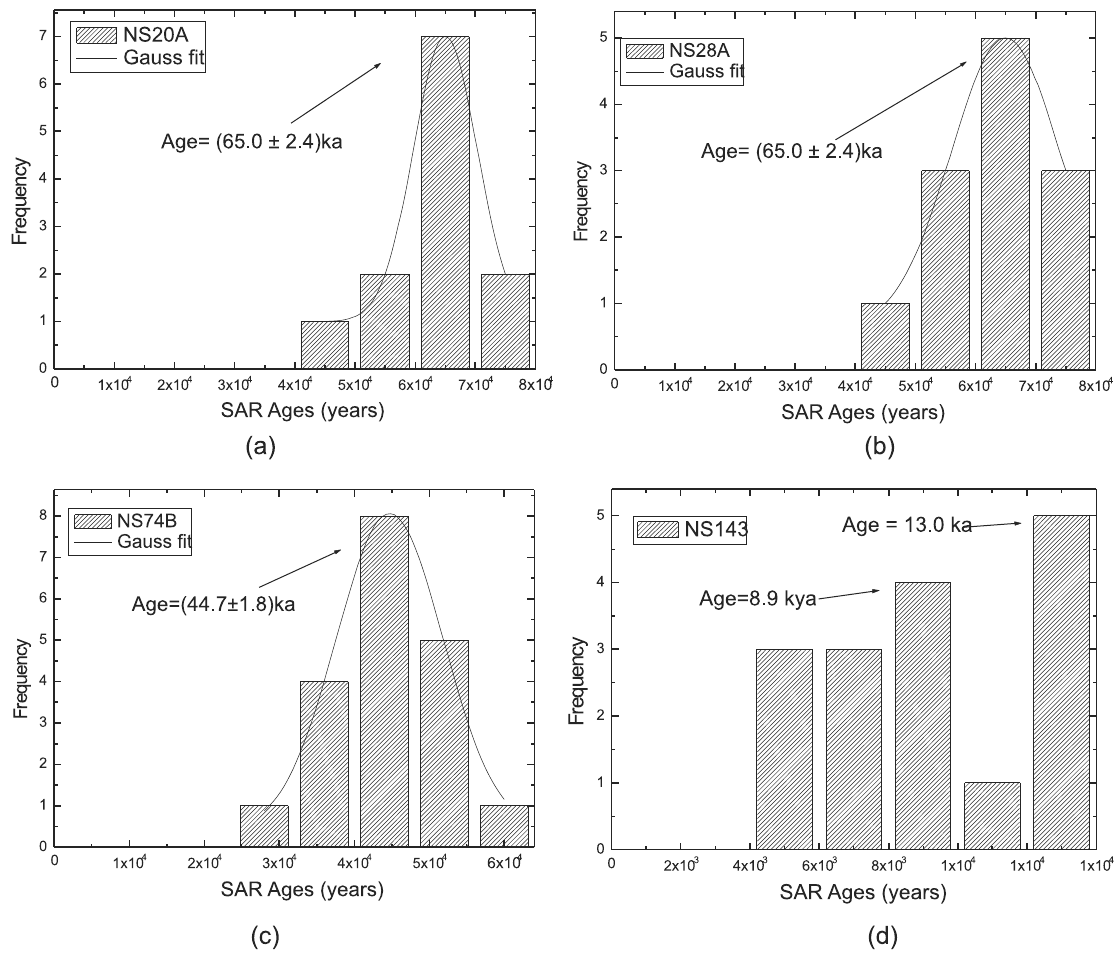
Fig. 3 – Histograms of ages utilizing the OSL method with SAR protocols for Quaternary sedimentary deposits of the alluvial floodplain of the GPA (NS20A, NS28B, NS143) and CGC (NS74)